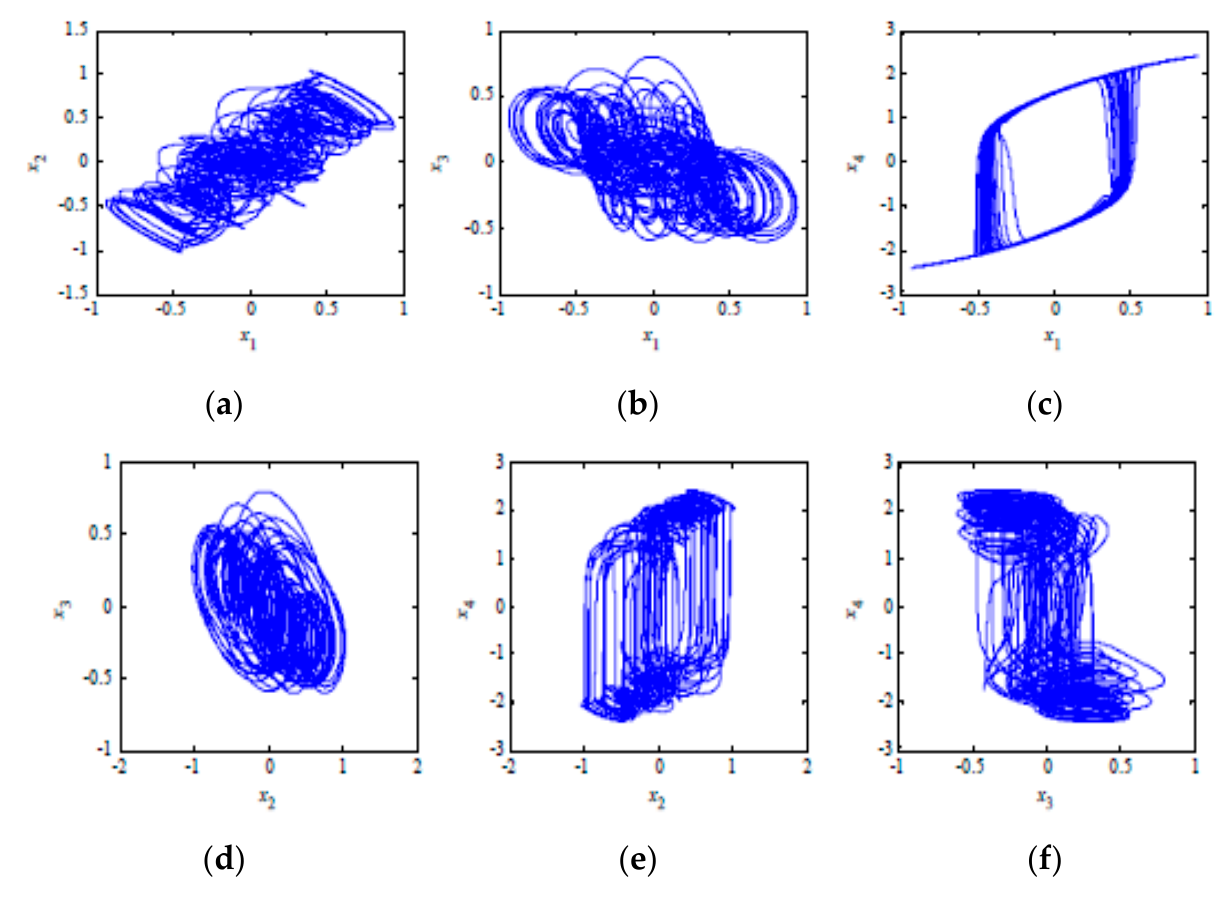
Figure 2. Chaotic behaviour of HNN with p = 0.3. ( a – c ) Between nodes X 1 and all other three nodes. ( d , e ) Between nodes X 2 with X 3 and X 4 . ( f ) Between nodes X 3 and X 4 .